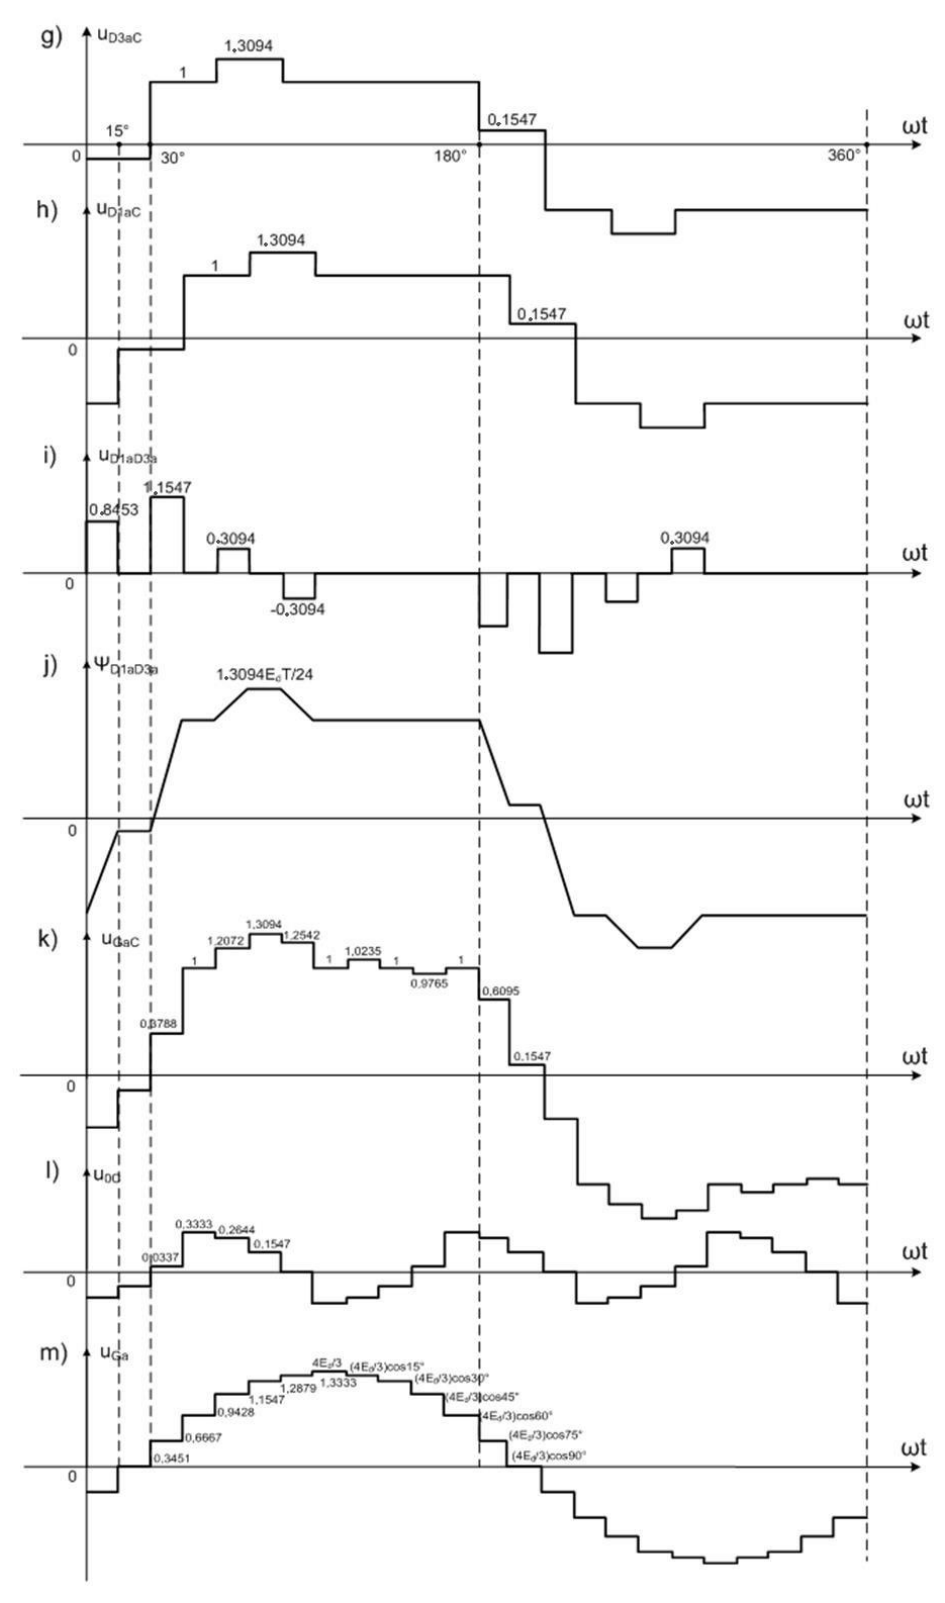
u , u (g–m). Figure 15. Design of the voltage and flux waveforms u D 3 aC , u D 1 aC 3 D aC 1 D aC